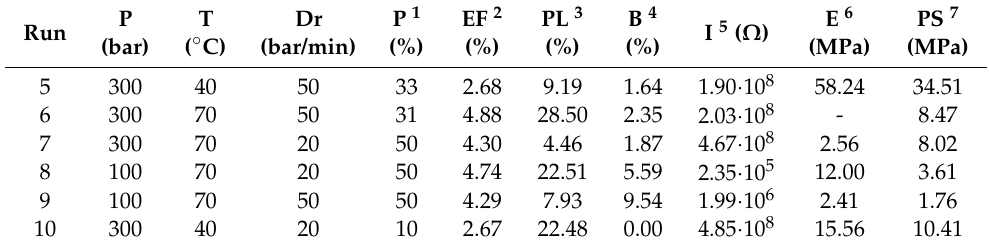
Table 2. Summary of data corresponding to runs and their resulting scaffolds.